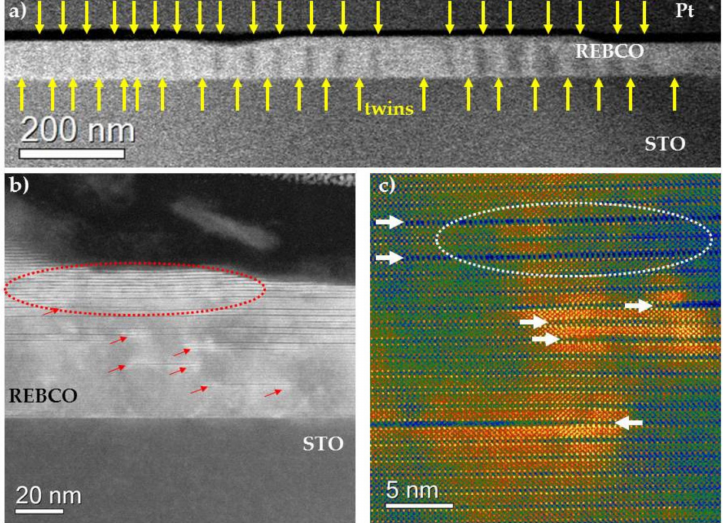
Figure 6. ( a ) High-angle annular dark-field scanning transmission electron microscopy (HAADF STEM) overview of YBCO-Gd 5% film deposited by the standard process (taken along the [100] / [010]YBCO zone axis), showing a high density of twins (highlighted by yellow arrows). ( b ) Annular dark-field (ADF) STEM image, demonstrating the presence of Y124 intergrowths. The strained areas of the YBCO matrix around Y124 intergrowths are visible as brighter contrast areas (marked by red arrows and ellipse). ( c ) High-resolution ADF STEM image colored in temperature scale: Y124 intergrowths are marked by white arrows. The edges of these intergrowths produced strained areas in the YBCO matrix (di ff raction contrast appeared as warmer contrast areas). The region with a visible concentration of Cu vacancies (ferromagnetic 1D clusters) is highlighted by the white